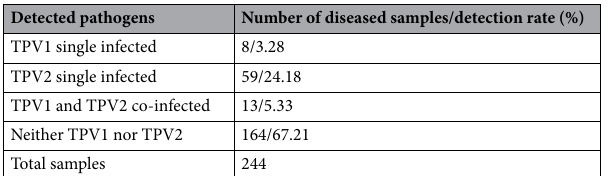
Table 6. RT-PCR detection results for TPV1 and TPV2 from 244 field tobacco samples.